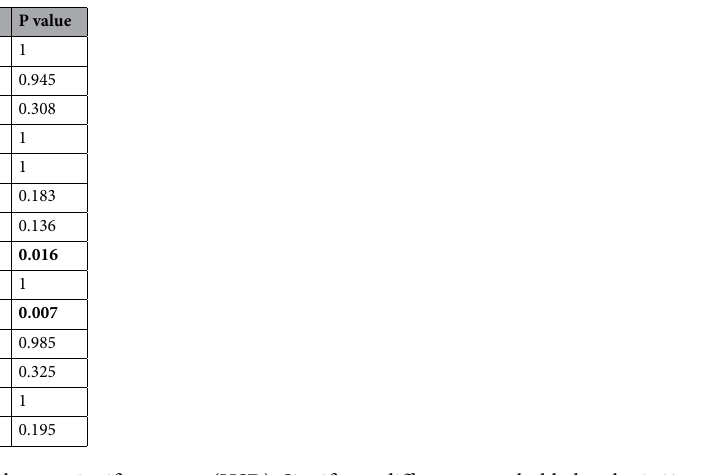
Table 4. Results from Tukey’s honest significant tests (HSD). Significant differences are bolded at the 95% confidence interval. ENR enrofloxacin; AMC amoxicillin-clavulanic acid; A + E amoxicillin-clavulanic acid and